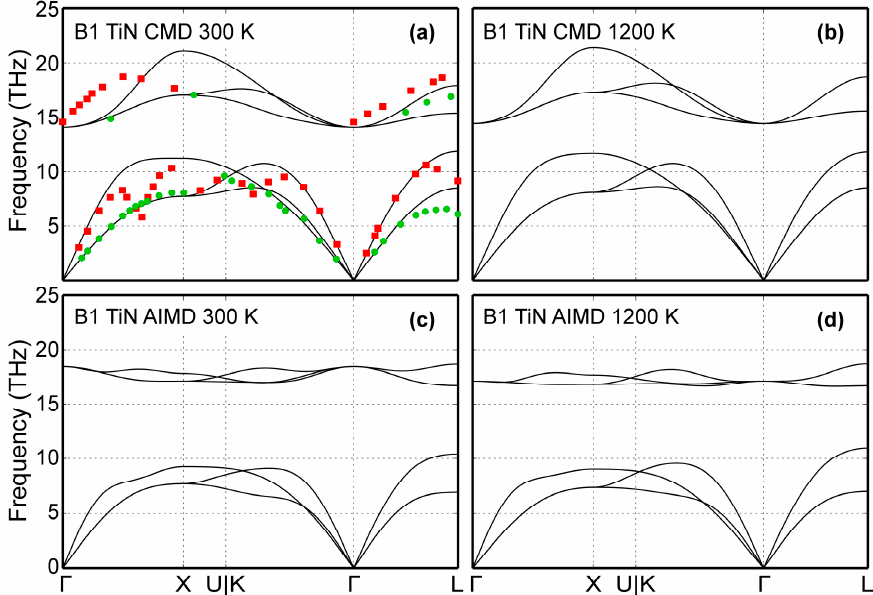
Figure 5. B1-TiN phonon dispersion curves calculated via: ( a ) CMD for 300 K, ( b ) CMD for 1200 K, ( c ) AIMD for 300 K, and ( d ) AIMD for 1200 K. Experimental data (green dots for transversal and red squares for longitudinal modes) obtained using neutron scattering measurements on B1-TiN 0.98 bulk samples from Ref. [111] are included for comparison.